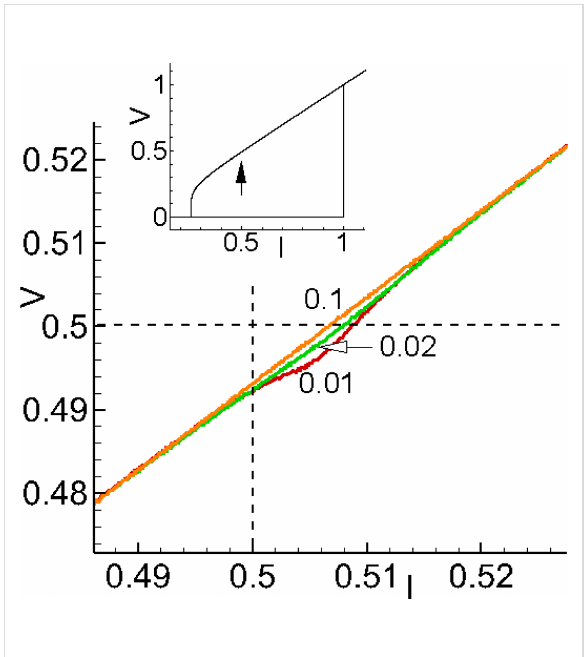
Figure 3: Part of the I – V characteristics of the φ 0 junction at G = 0.05, r = 0.05, and different values of Gilbert damping. The numbers show the α value. The inset shows the total I – V characteristics and the arrow indicates the resonance region.